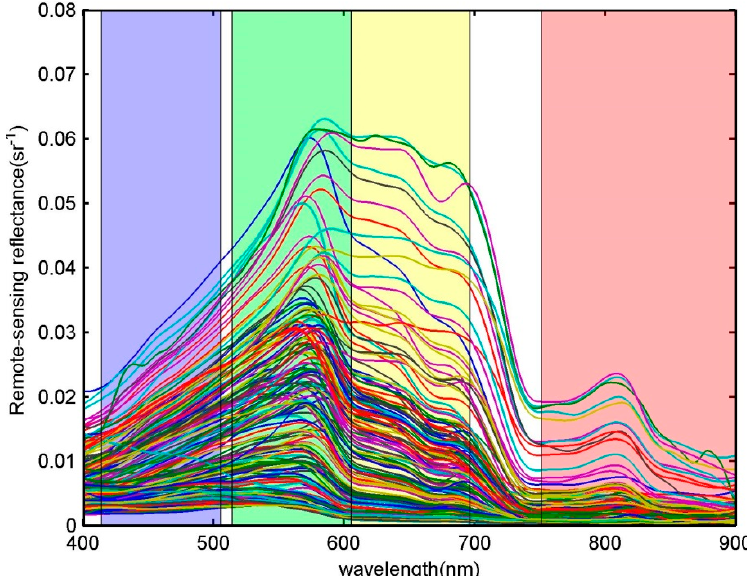
Figure 2. Spectral remote sensing reflectance R rs ( λ ) of Case 2 water, measured from turbid coastal waters along the east China coast ( n = 748). The overlaid colored areas denote the four CZI bands, whose boundaries are determined by the 1% peak response. The lines of different colors represent the data measured at different stations.